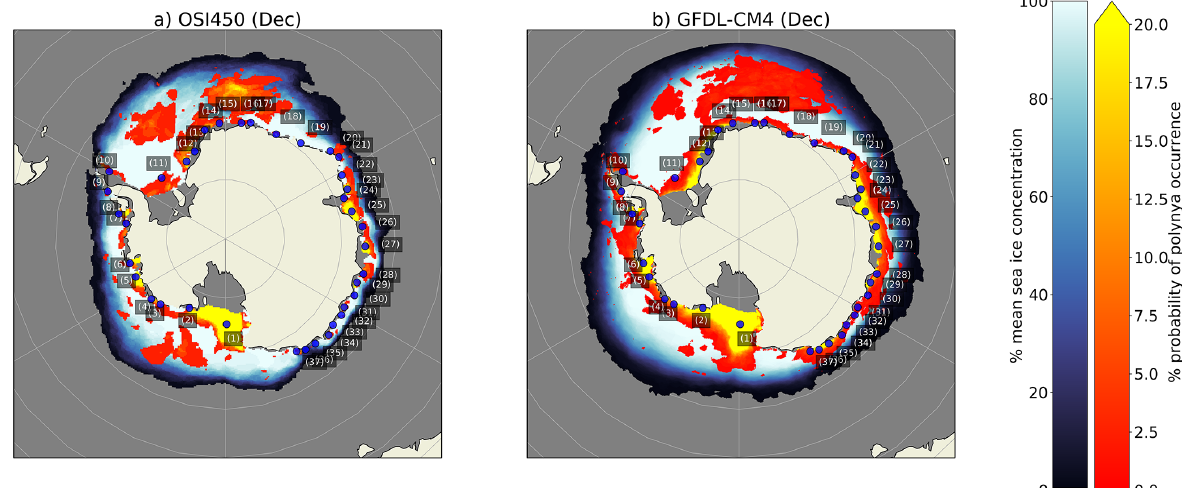
Figure 5. Frequency and location of polynya occurrences in December (colours) with the positions of coastal polynyas (blue dots, locations from Arrigo and Van Dijken, 2003) for the common time interval of (a) the observed satellite sea ice (OSI450) and (b) the GFDL-CM4 CMIP6 model with the highest spatial resolution (25 ×